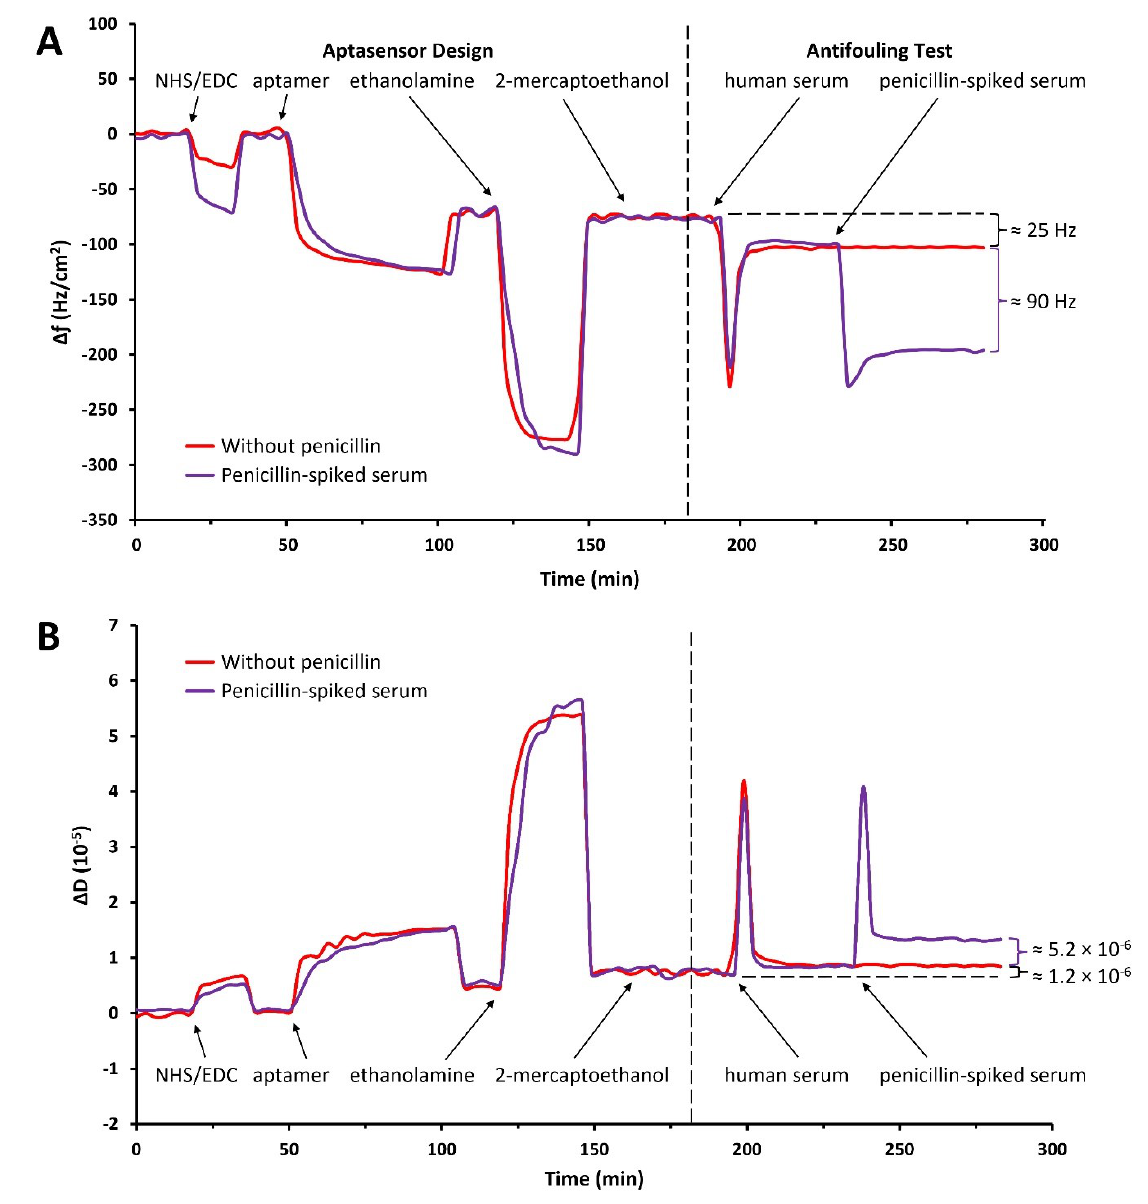
Figure 13. ( A ) Frequency and ( B ) dissipation variations when building the DTT COOH aptasensor in- flow and testing its antifouling properties in undiluted human serum with and without 10 µM pen-